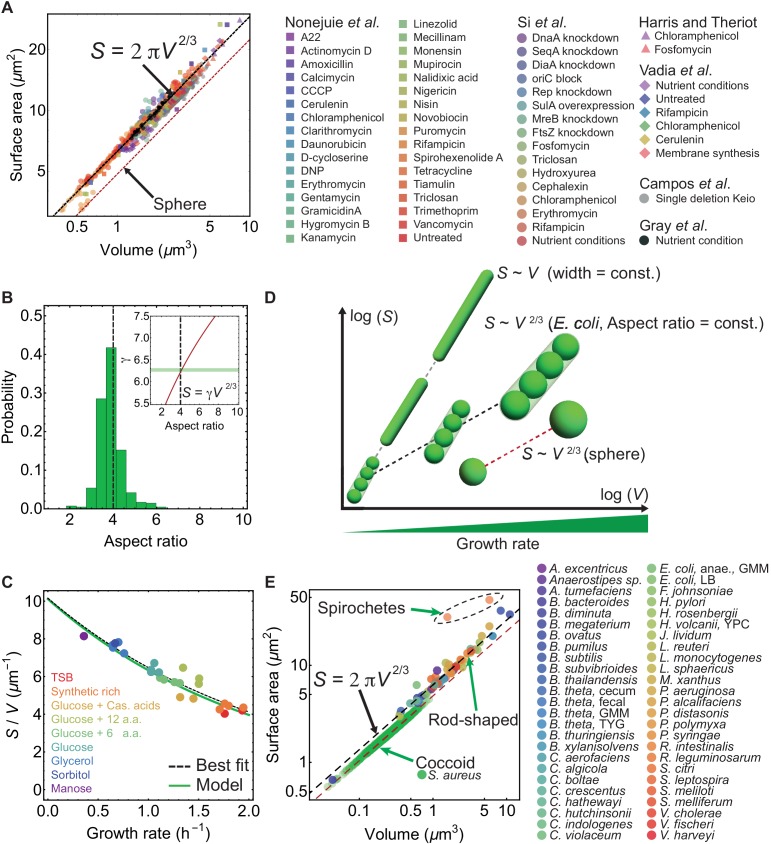
Surface-to-volume scaling in E. coli and other rod-shaped bacteria.(A) E. coli cells subjected to different antibiotics, nutrient conditions, protein overexpression/depletion, and single gene deletions (Nonejuie et al., 2013; Si et al., 2017; Harris and Theriot, 2016; Vadia et al., 2017; Campos et al., 2018; Gray et al., 2019), follow the scaling relation between population-averaged surface area (S) and volume (V): S=γ⁢V2/3 (legend on the right, 5011 data points; Supplementary file 1). Best fit shown in dashed black line for steady-state data from Si et al. (2017) gives γ = 6.24 ± 0.04, and a power law exponent 0.671 ± 0.006. For single deletion Keio set (Campos et al., 2018), the best fit curve is S=5.79⁢V2/3. (B) Aspect-ratio distribution for cells growing in steady-state, corresponding to the data in (A) (Si et al., 2017). (Inset) Relationship between γ and aspect ratio η for a sphero-cylinder (red line). Best fit from (A) shown with horizontal green band gives aspect ratio 4.14 ± 0.17. (C) S/V vs growth rate. Model line uses S=2⁢π⁢V2/3 and the nutrient growth law (Equation 1). Data from Si et al. (2017). (D) S-V relation for various bacterial cell shapes. Black dashed line: Small, medium, and large rod-shaped cells with a conserved aspect ratio of 4 follow the relation: S=2⁢π⁢V2/3. Gray dashed line: Filamentous cells with constant cell width follow the scaling law: S∼V. Red dashed line: Spheres follow S=62/3π1/3V2/3. (E) S vs V for 49 different bacterial species (Sato, 2000; Trachtenberg, 2004; Pelling et al., 2005; Wright et al., 2015; Deforet et al., 2015; Desmarais et al., 2015; Harris and Theriot, 2016; Ojkic et al., 2016; Quach et al., 2016; Carabetta et al., 2016; Chattopadhyay et al., 2017; Lopez-Garrido et al., 2018; Gray et al., 2019), and one rod-shaped Archaea (H. volcanii) (Supplementary file 2). Rod-shaped cells lie on S=2⁢π⁢V2/3 line, above the line are Spirochete and below the line are coccoid. For coccoid S. aureus exposed to different antibiotics best fit is S=4.92⁢V2/3, with preserved aspect ratio η = 1.38 ± 0.18. Red dashed line is for spheres.